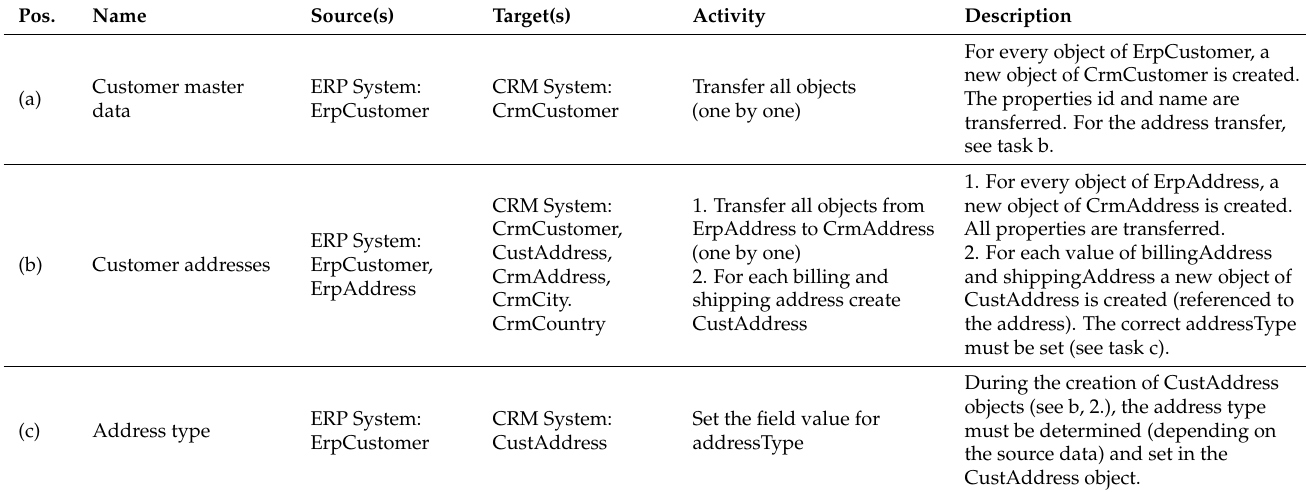
Table 3. Step 3: Identification of data integration tasks for the